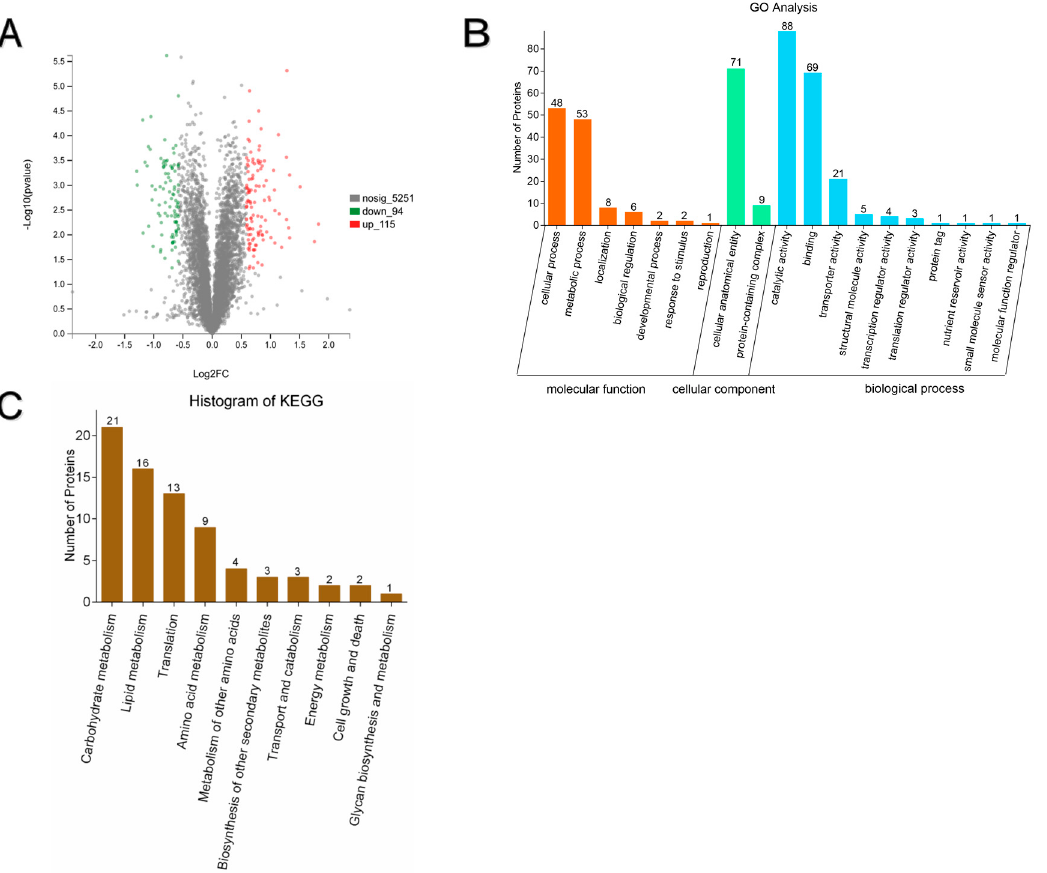
Figure 5. Summary of regulated proteins. The value of protein expression is significantly ( p < 0.05) differentially expressed (>1.5-fold) between two groups. ( A ) The volcano plot of regulated proteins. Red dots represent up-regulated, green dots represent down-regulated and grey dots represent no significance (compared to the 0.98aw group). The x -axis indicates fold change (log 2 FC), and the y -axis indicates p -value (log 10 p ). ( B ) GO categorization of different expressed proteins of two a w groups ( C ) Top 10 of KEGG pathways of different expressed proteins. The x -axis indicates the pathways, and the y -axis indicates the number of